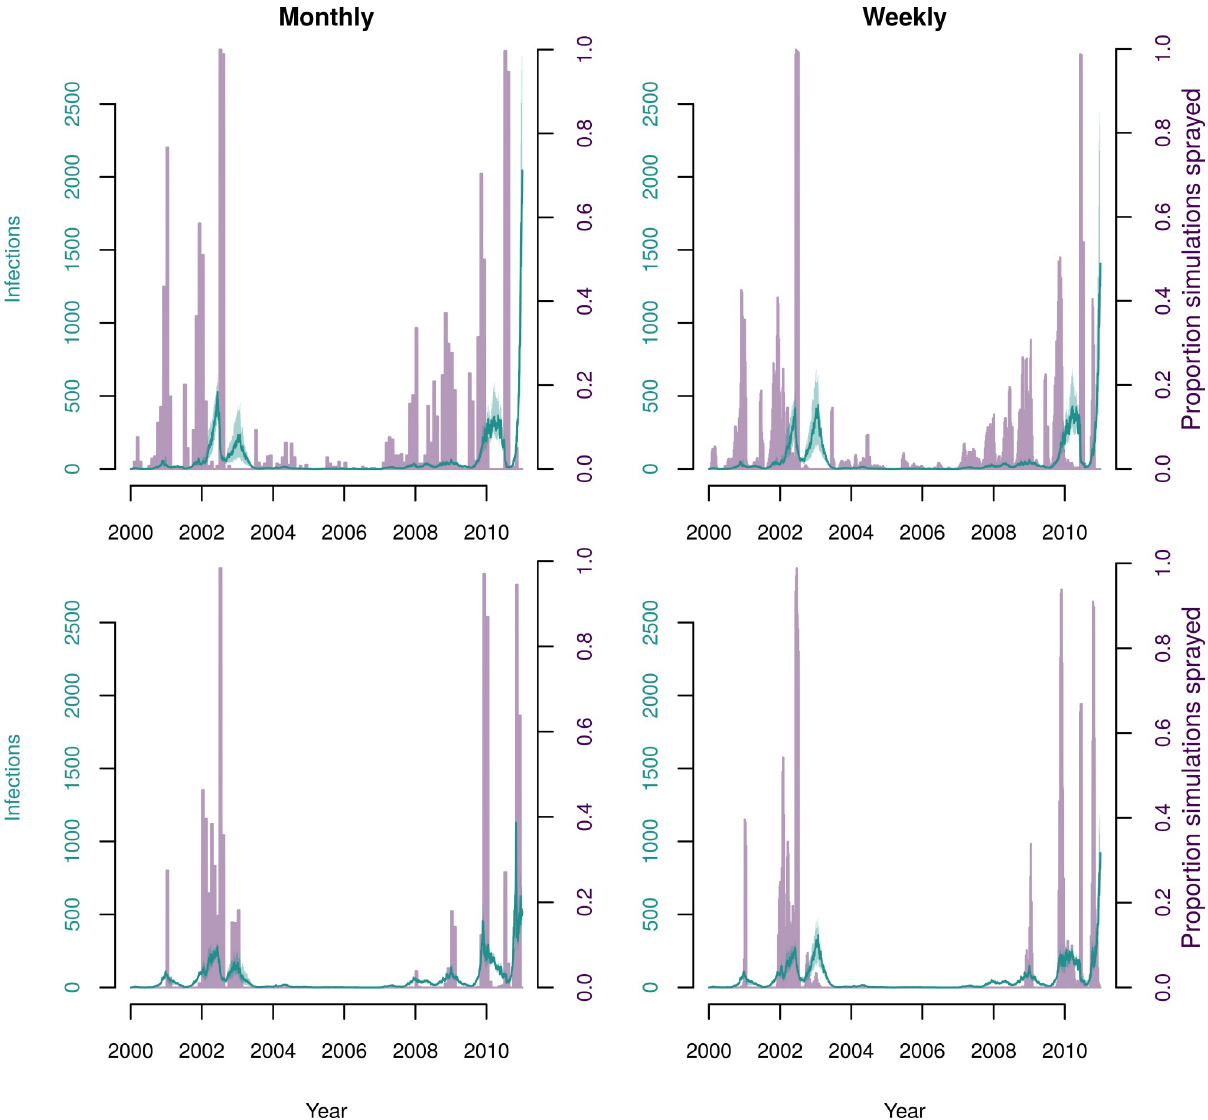
Fig 7. Comparison of frequency of ULV spraying and human incidence with different fixed thresholds to initiate spraying. In all panels, lilac bars represent the proportion of simulations which were undertaking spraying on the given day, the green line represents median incident infections, and the green shading represents the interquartile range. The left column shows when thresholds were monitored monthly, and the right column when they were monitored weekly. In the top row, the threshold was low (400 and below for monthly, 130 and below for weekly), and in the bottom row, the threshold was high (above 400 for monthly, and above 130 for